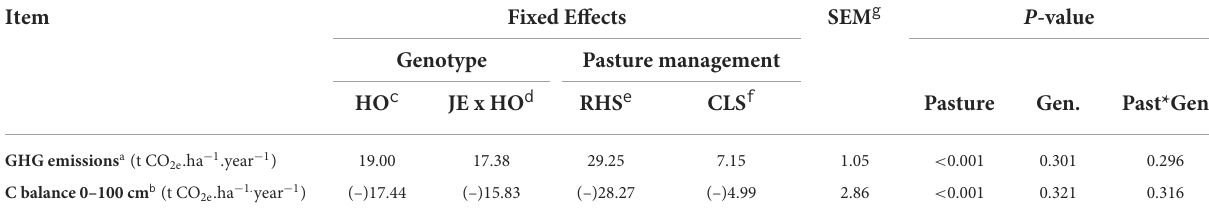
TABLE 3 Greenhouse gas emissions and carbon balance for two cow genotypes and two levels of intensification in grazing management systems—Atlantic Forest as reference area to calculate carbon stocks. Item